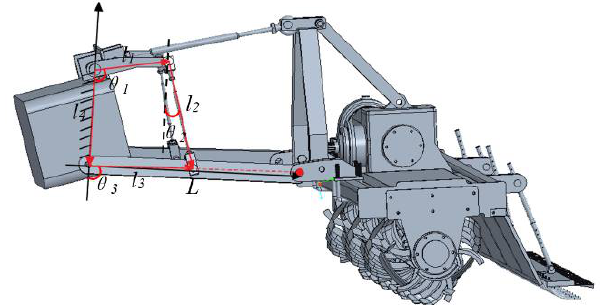
Figure 3. Structure of tractor rear hitch. Note: l 1 is the length of the upper swing arm, cm; θ 1 is the angle of the upper swing arm, (°); l 2 is the length of the connecting rod, cm; θ 2 is the steering angle of the connecting rod, (°); l 3 is the length from the lift arm shaft to the connecting arm connection point, cm; θ 3 is the steering angle of the lift arm, (°); l 4 is the installation distance between the lifting arm and the upper swing arm, cm; L is the length of the lift arm.